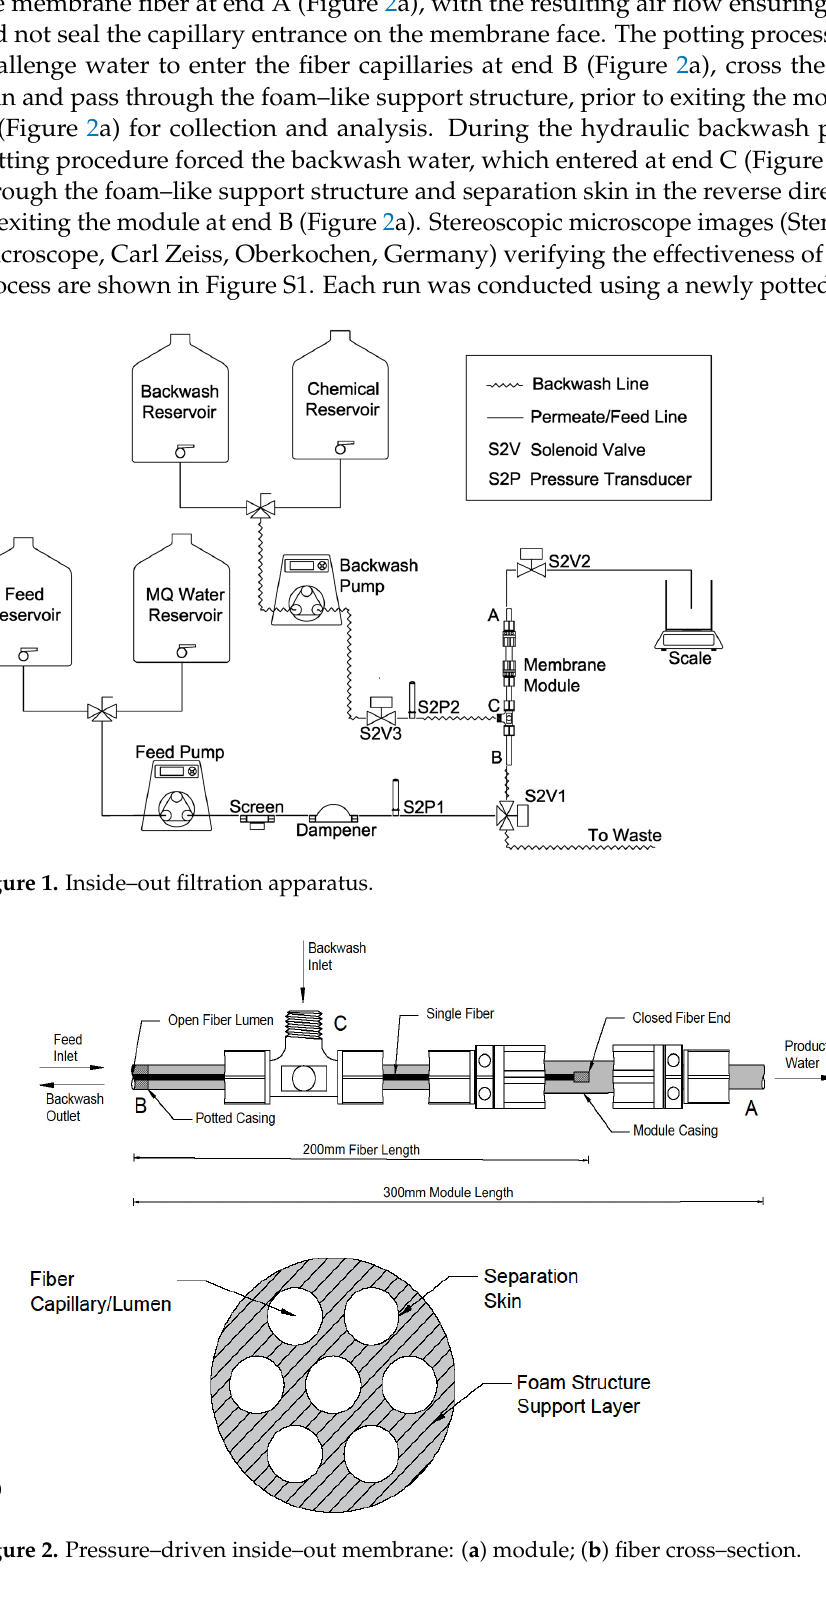
Figure 2. Pressure – driven inside – out membrane: (a) module; (b) fiber cross – section.